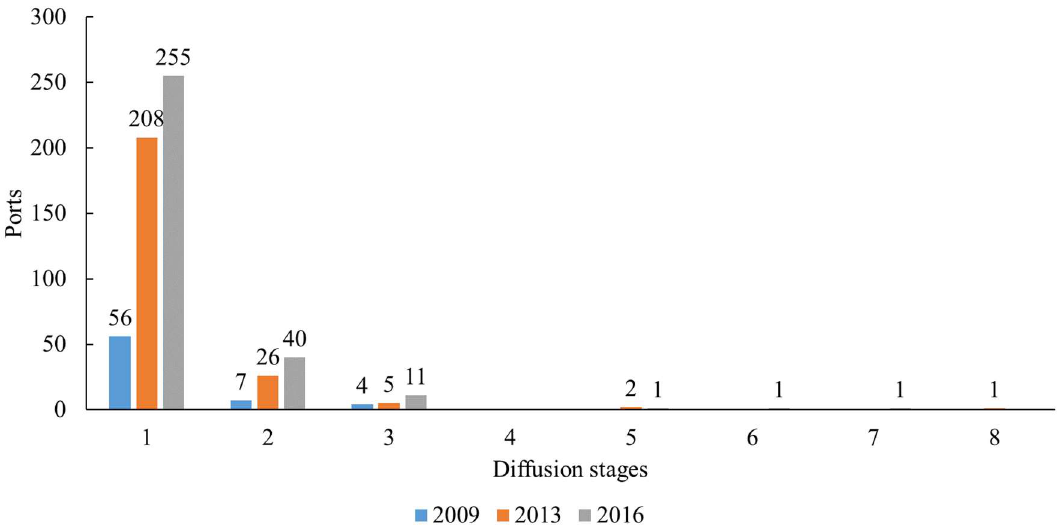
Figure 2. Number of influencing ports at different diffusion stages.